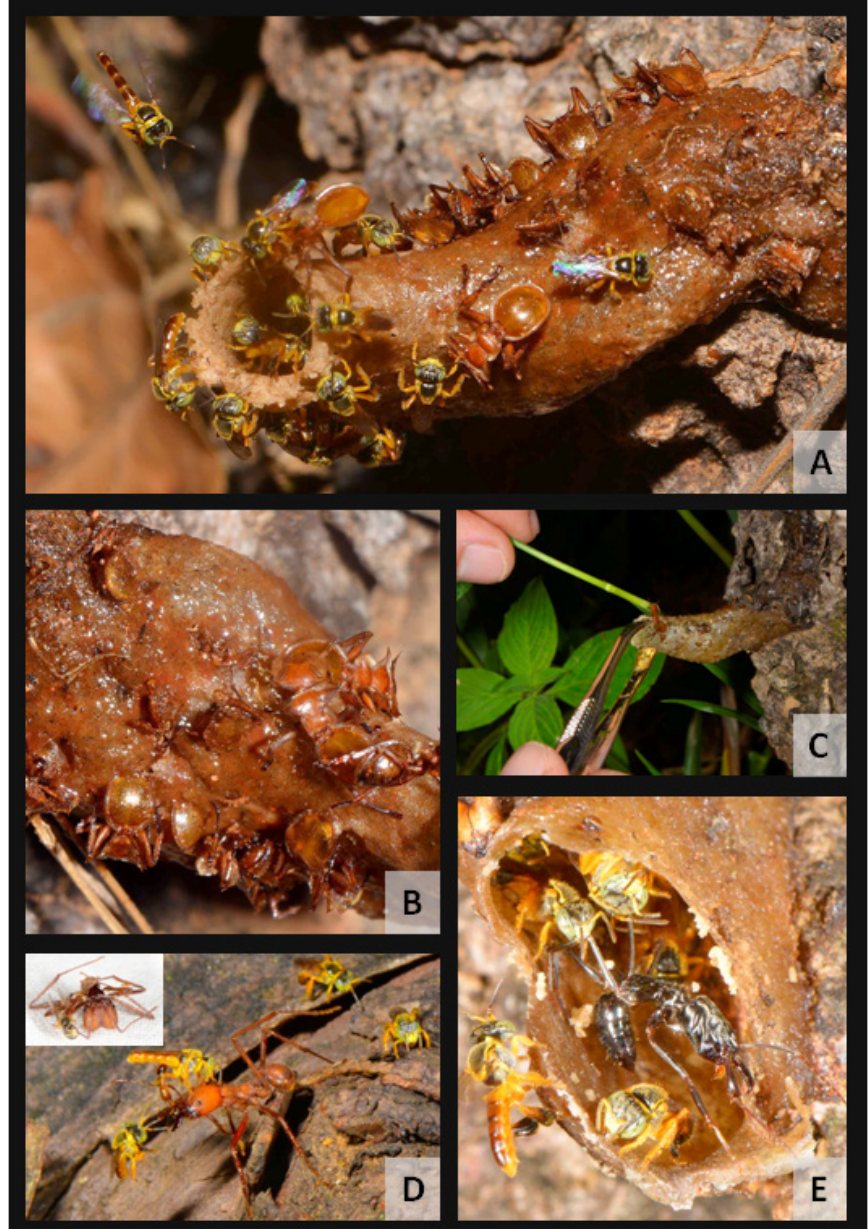
Fig 1. Functional role of sticky particles deposited on the external side of Tetragonisca angustula nest entrance. A. Entrance tube as it was found by the authors in August 2014, check on the dead ants covered by thin layers of the same material used in the nest entrance, B. close view of Cephalotes clypeatus stuck in the nest entrance found in the field, C. Ants ( C. clypeatus ) being experimentally moved to the nest entrance tube for monitoring purpose, D. Fighting behaviour between T. angustula and Atta sexdens experimentally moved to nearby the nest entrance and the resulting dead ant with a bee attached to its antenna, E. Non-fighting behaviour related to a large ant ( Odontomachus bauri ) partially immobilized by the entrance tube sticky